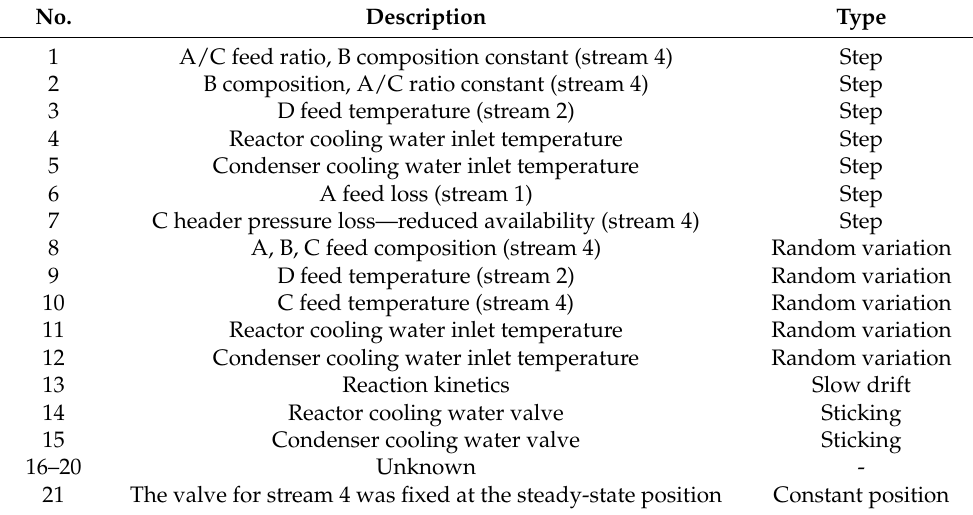
Table 6. Process faults for the Tennessee Eastman